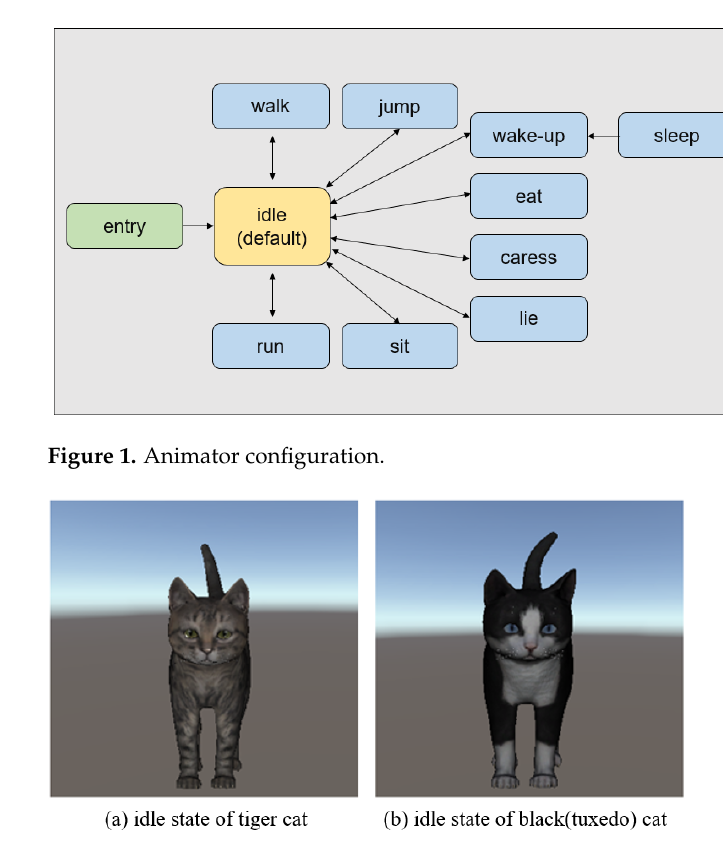
Figure 2. Idle state of virtual